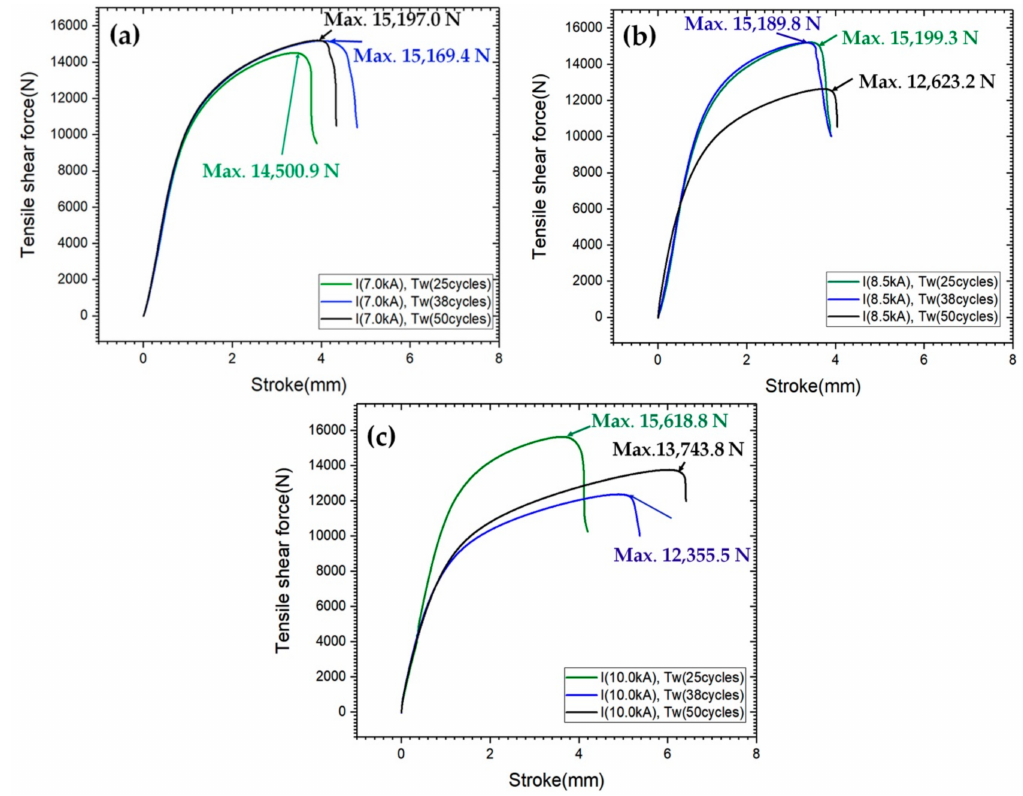
Figure 6. Tensile shear force of lap joints under 25, 38, and 50-cycle welding times given weld currents of: ( a ) 7.0; ( b ) 8.5; ( c ) 10.0